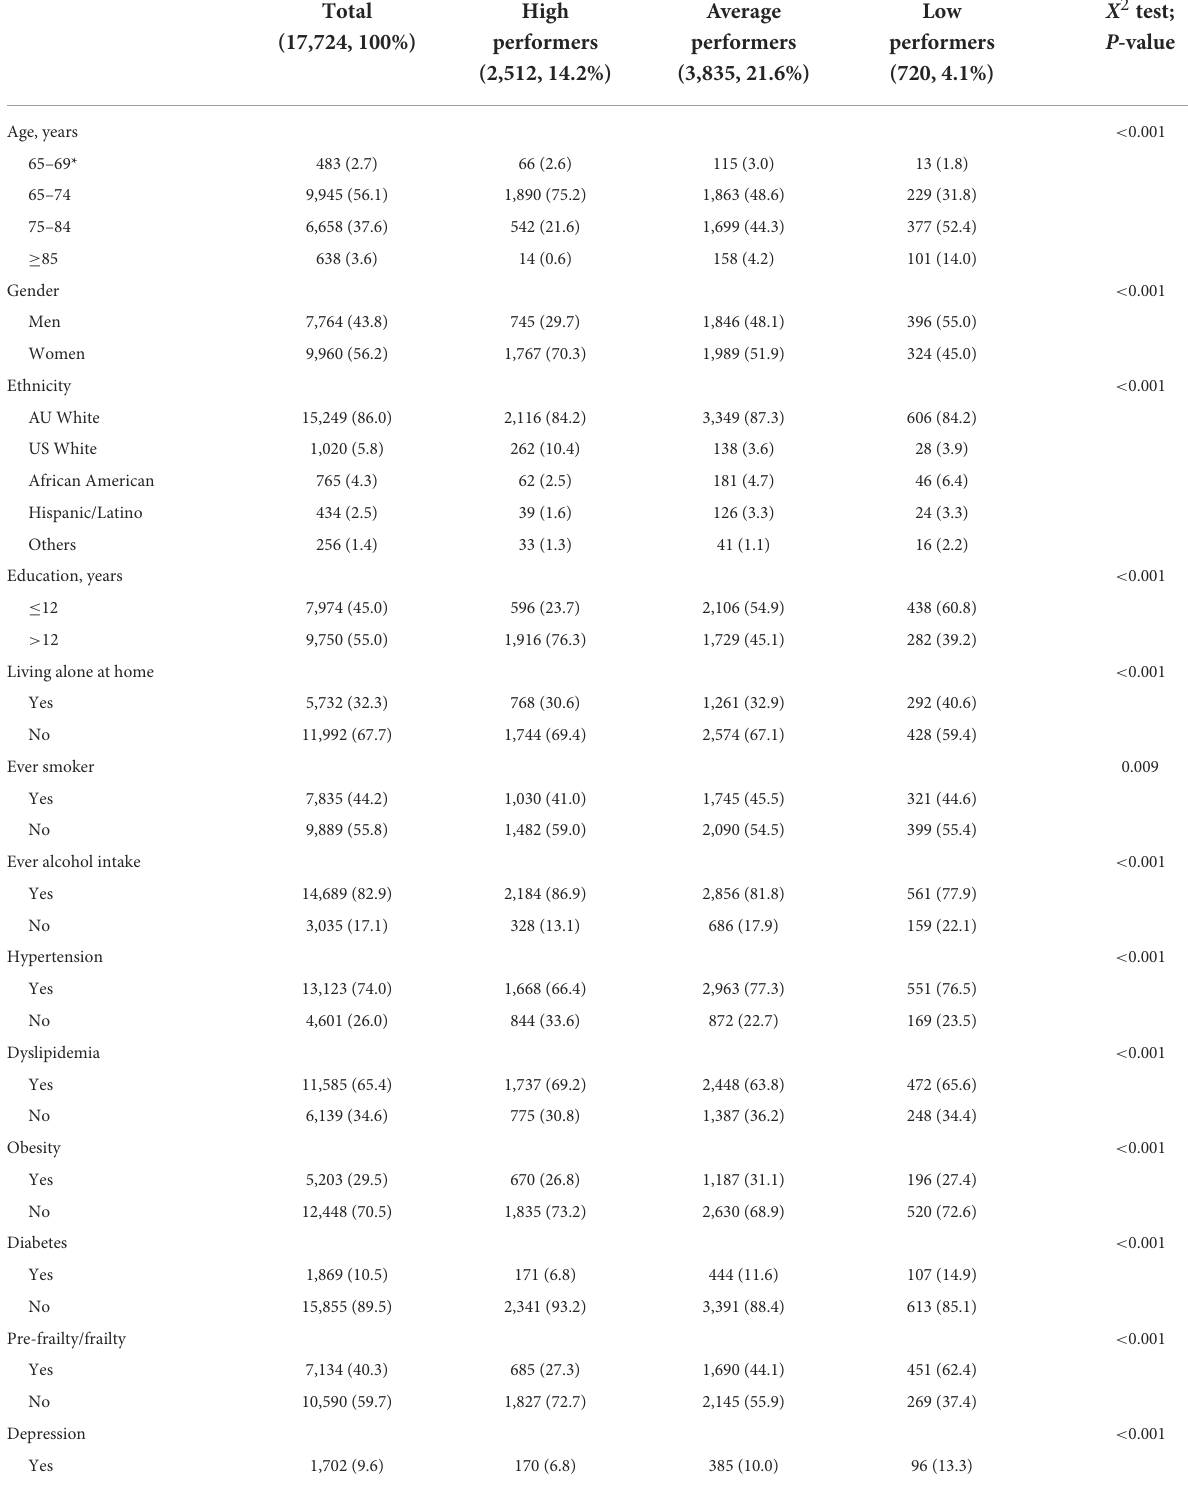
TABLE 1 Baseline characteristics of participants included in the study ( N =